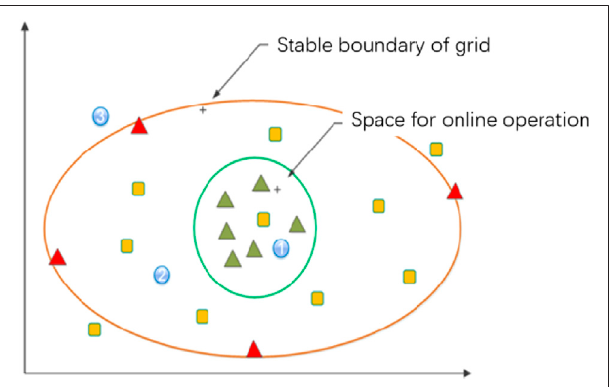
FIGURE 1 | illustration on grid operation sample